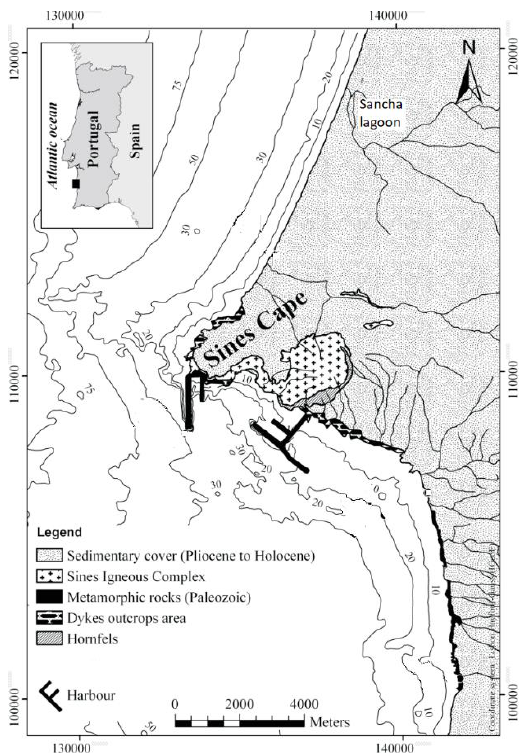
Figure 1. Geologic setting of the Sines complex (adapted from Pombo et al. 2006).